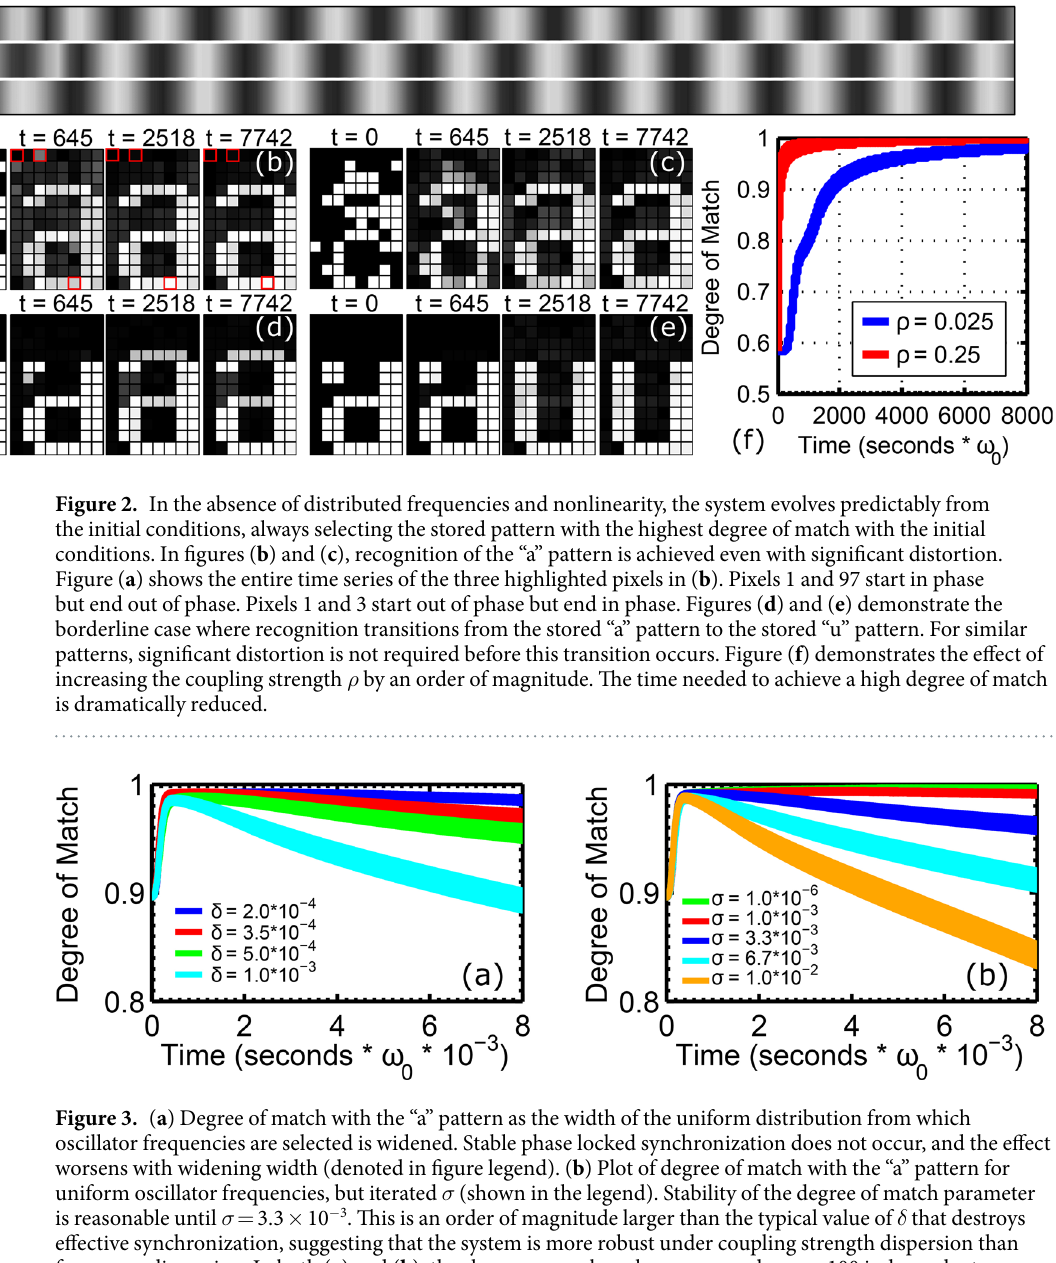
towards the configuration with the higher degree of match, but in its presence, the loss of stability over time can lead to selection of the other pattern (Fig. 4). If the distribution of frequencies is broad enough, then the stored patterns need not even be highly overlapping; the system will be unable to distinguish between a wide number of patterns; pattern recognition in the absence of phase synchronization with widely distributed frequencies is therefore unreliable. Physically, frequency dispersion arises from variability in the resonator fabrication process. Coupling strength dispersion is motivated by similar considerations; through whatever means coupling is achieved (mechanical, capacitive, radiation), perfect precision is elusive in an experimental setting. Given this, as the encoding of pat- terns as stable fixed points in the dynamics is accomplished by a particular coupling matrix (equation (10)),